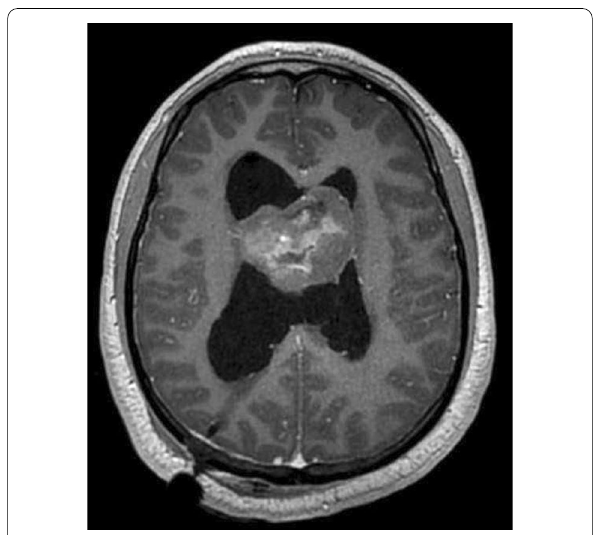
Fig. 2 Pathological features of a case of neurocytoma. a Shows monomorphic cells with vesicular nuclei, clear cytoplasm (oligo‑like), and delicate arborizing blood vessels (40 ). b Neu‑N positive nuclear staining (40 ). c Synaptophysin granular cytoplasmic positivity (40 × ×